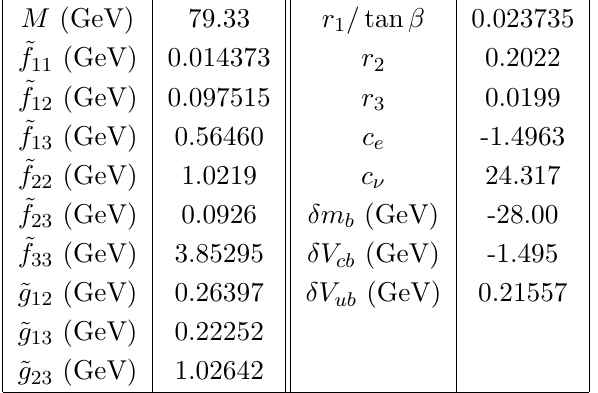
Table 3 . Fit values for the model parameters at the GUT scale for a sample model (cid:12)t with type-I seesaw. This (cid:12)t utilized the blue initial position for input from table